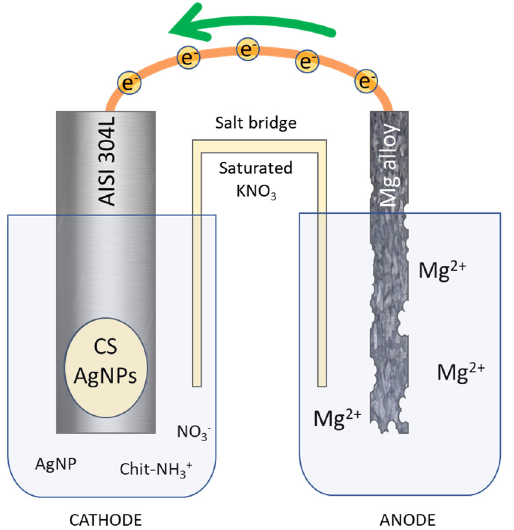
Figure 1. Schematic representation of galvanic deposition of chitosan/Ag nanoparticles. The cathodic solution was prepared in different steps, in order to allow the formation of the complex between chitosan and silver ions. Initially, in 100 mL of Milli-Q water at 70 °C, 1 mL of pure acetic acid was added to promote the solubilization of chitosan thanks